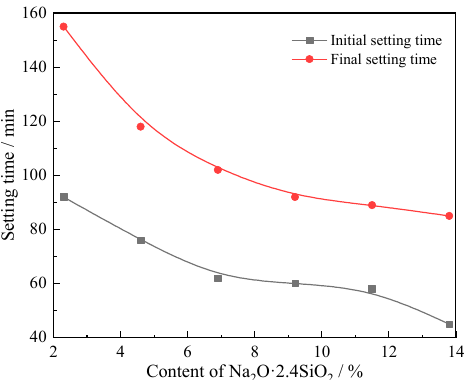
Figure 7. Setting time of composite alkali-activated cementitious materials.